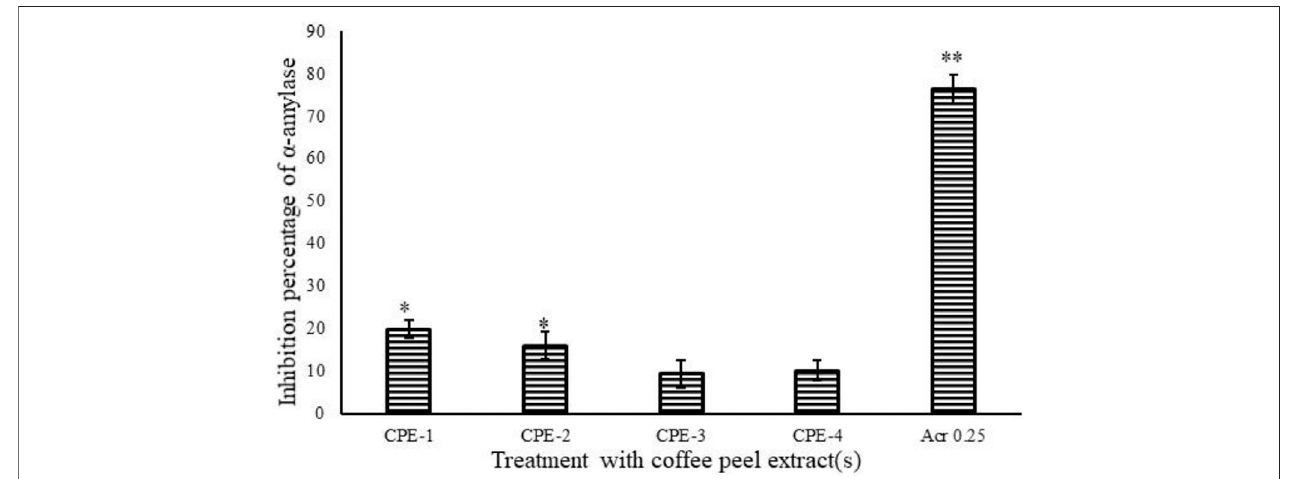
FIGURE3| Inhibitionpercentageof α -AbyacarboseandCPEs(CPE-1 (cid:1) 0.5 g,CPE-2 (cid:1) 0.75 g,CPE-3 (cid:1) 1 g,andCPE-4 (cid:1) 1.25 g).Allthevaluesareexpressedas mean ± SD and are signi fi cantly different at * p ≤ 0.05 and ** p ≤